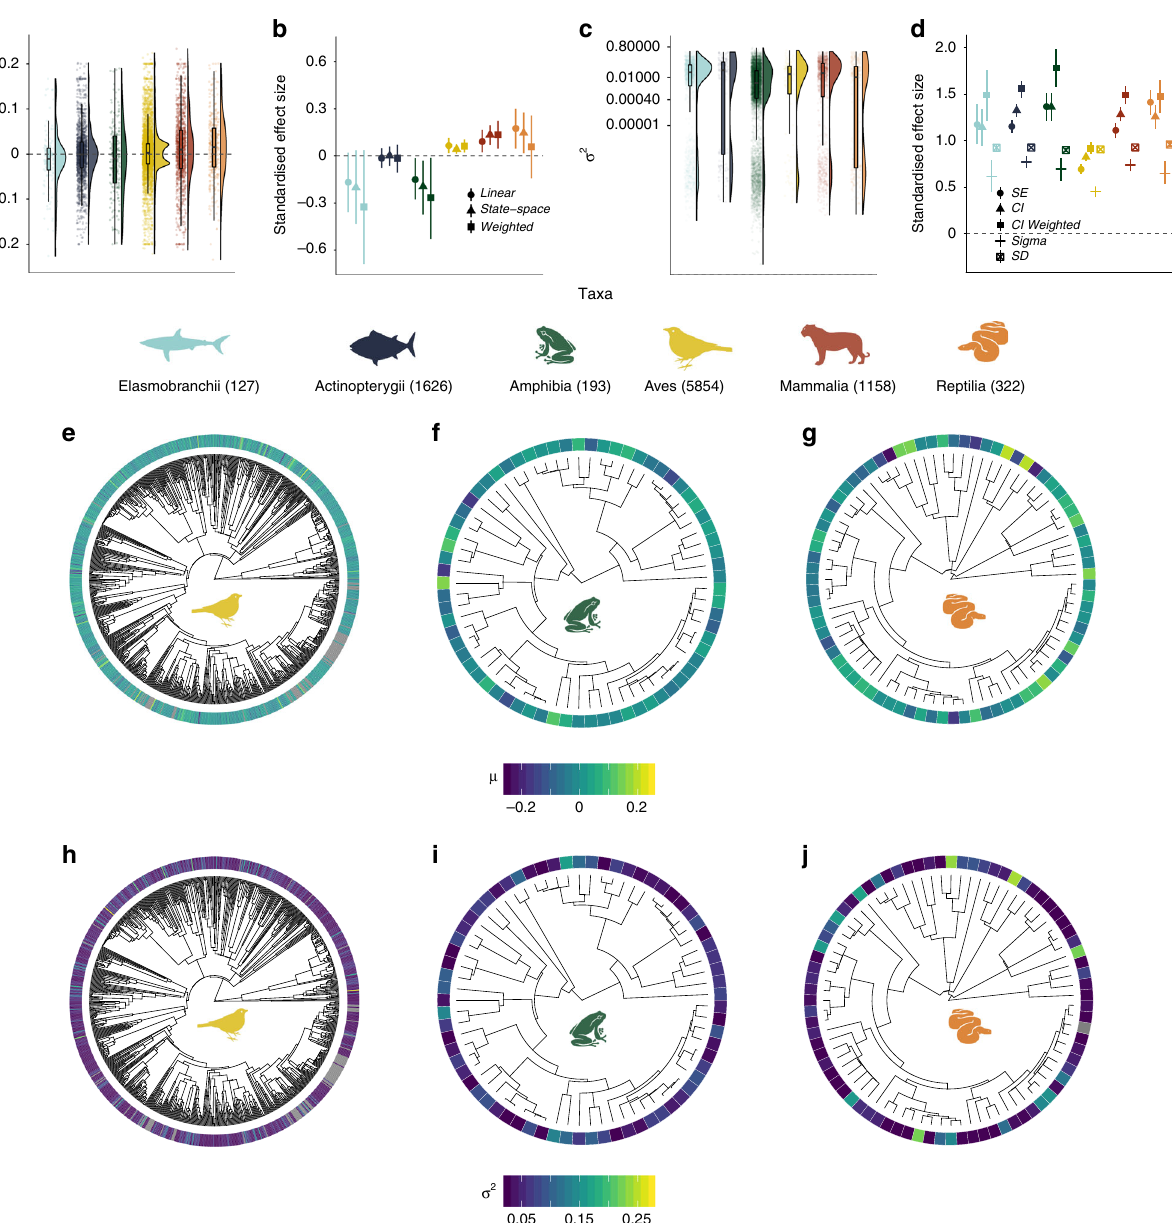
Fig. 2 Population trends and fl uctuations vary more among, rather than within, taxa, with amphibians being the only group showing pronounced declines over time. There were no distinct phylogenetic patterns in population trends and fl uctuations e – j . For details on phylogenetic models, see methods and Supplementary Fig. 15. Grey colour in the heatmap in h shows species for which no population trend data were available. The numbers in the legend for a – d show sample size for each taxon. The μ values of population trend a , b , e – g and the σ 2 values of population fl uctuation c , d , h – j were derived from state-space model fi ts of changes in abundance over time for each population. a and c show the density distribution of population trends across taxa, the raw values (points) and boxplots (including the mean, fi rst and third quartiles and boxplot whiskers that cover 1.5 times the interquartile range). b and d show the standardised effect sizes (centre of error bars) and the 95% credible intervals of population trends b and fl uctuations d across the fi ve studied taxa. Error bars in b and d show 95% credible intervals. See Fig. 1 caption for further details on effect sizes and Supplementary Tables 2 and 4 for model outputs. Icon credits: bird by Hernan D. Schlosman, snake and frog by parkjisun, fi sh by Julia